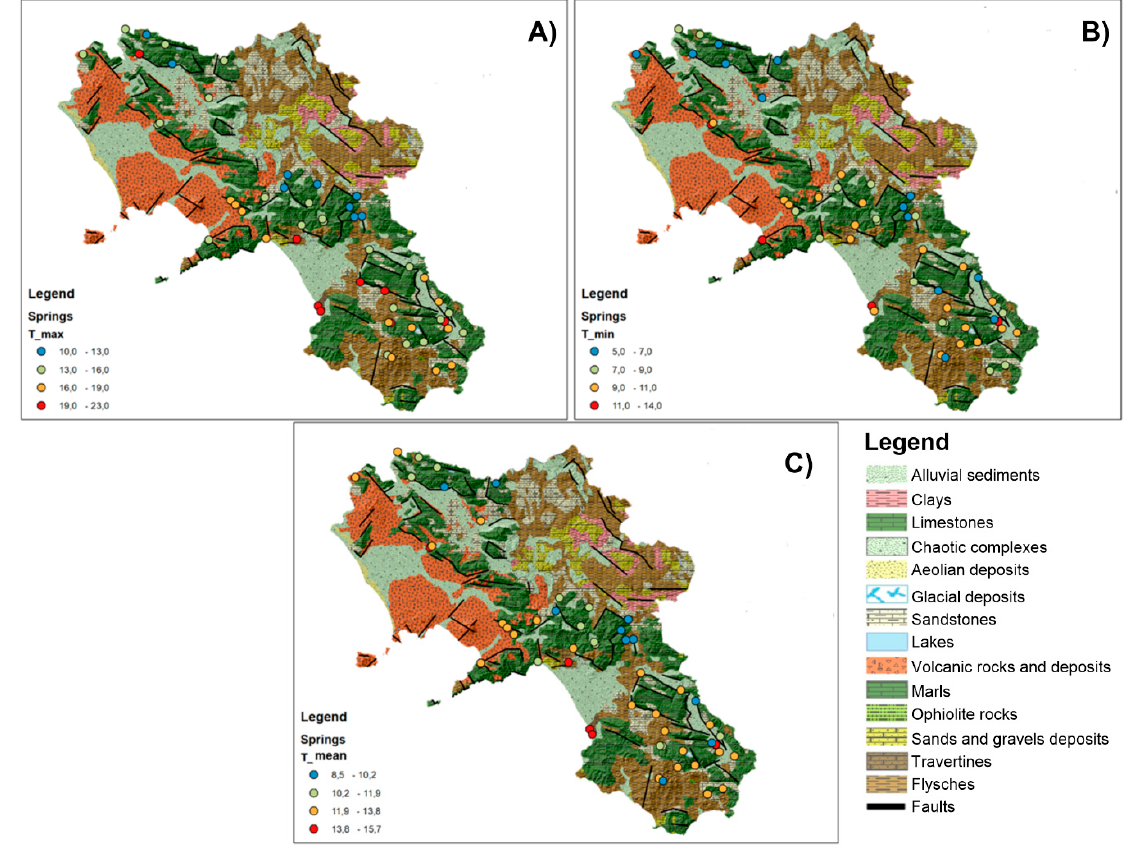
Figure 4. ( A ) Average values of maximum spring water temperatures. ( B ) Average values of minimum spring water temperatures. ( C ) Average values of mean spring water temperatures. The geological formations are in conjunction with the main fault system.